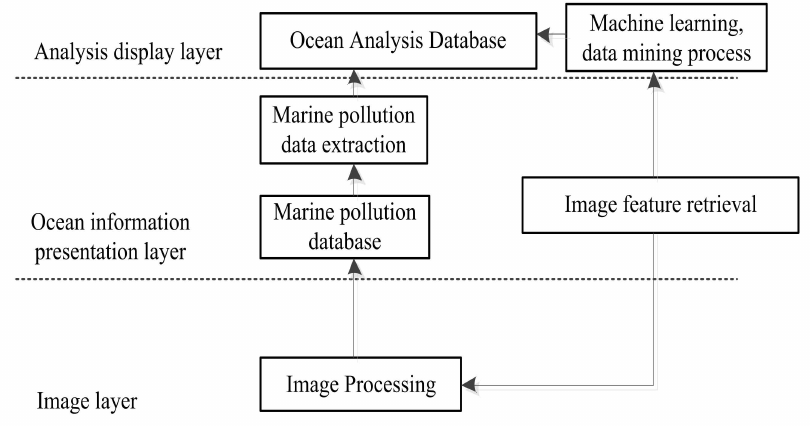
Figure 1. Intelligent remote sensing monitoring structure of corrosive pollution information in marine